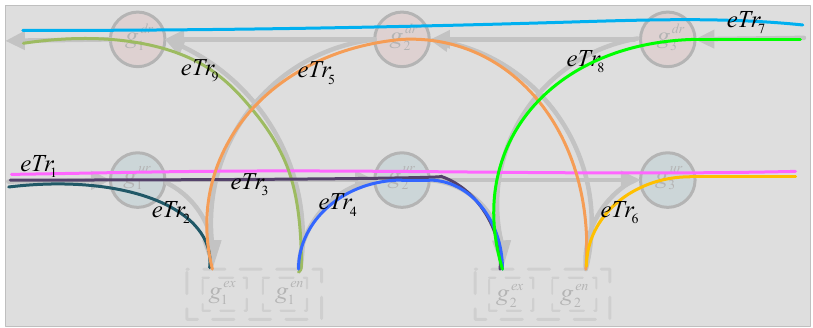
Figure 3. An example of road trajectory.